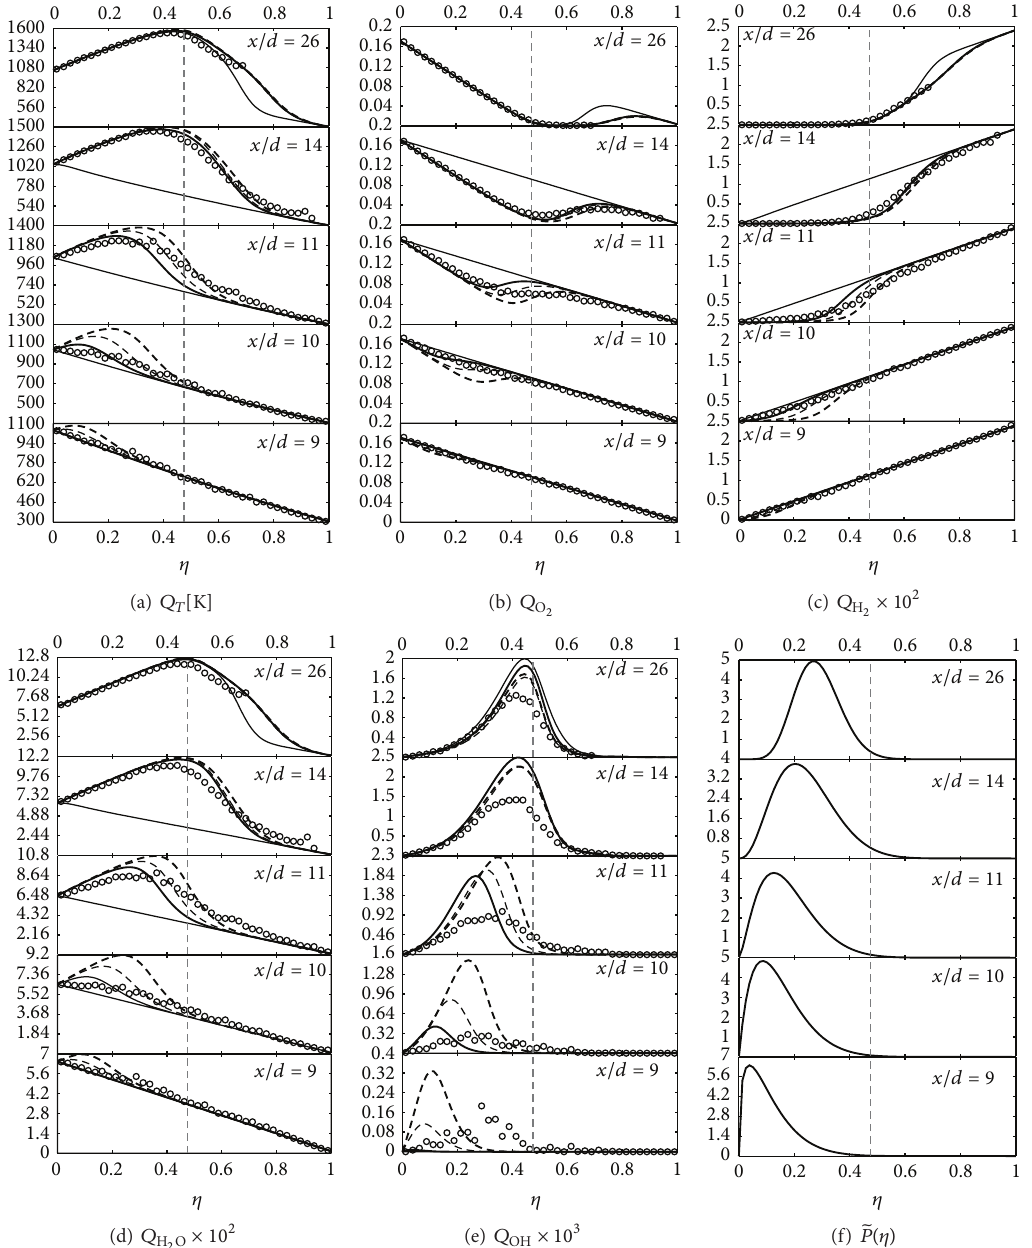
Figure 17: Conditional profiles at 𝑥/𝑑 = 9, 10, 11, 14 and 26 and 𝑦/𝑑 = 1.47 using different chemical kinetic mechanisms: (a) 𝑄 𝑇 , (b) 𝑄 (×10 2 ) , (d) 𝑄 (×10 2 ) , (e) 𝑄 (×10 3 ) , and (f) ̃𝑃(𝜂) . In (a)–(e): thick solid lines, Mueller et al. [40]; thick dashed lines, Li et al. [41]; 𝑄 H 2 H 2 O OH thin solid lines, Burke et al. [42]; thin dashed lines, ´O Conaire et al. [43]; symbols, experimental data (see the Appendix). The vertical dashed line indicates the location of the stoichiometric mixture fraction. The CSDR is modelled using Girimaji’s model and 𝑇 𝑐 = 1045 K.